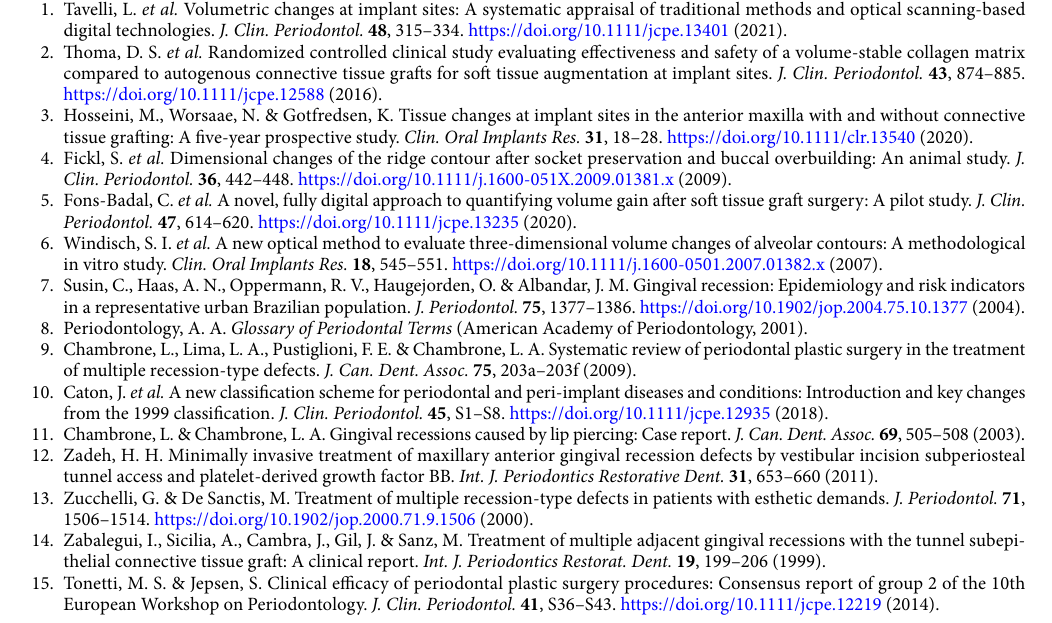
Two different methods to measure the soft-tissue thickness were applied using the protocol presented in Sup- plementary Table 1. The first method calculated the mean gingival thickness (2DTHK) and maximum gingival thickness (2DTHK Max) for each case at every time point, as seen in Fig. 3A. The second method involved a 3D assessment by limiting the recession in T0, T1, and T2 at the same time using transparencies to obtain the new volume of tissue over the denuded root for precise quantification of the tissue, as seen in Fig. 3B. In this case, the region of interest comprised the entire area of grafted soft tissue on the previously exposed root surface. Thus, the mean thickness of the marginal soft tissue (3DTHK) on the formerly exposed root surface, the mean gingival thickness (3DTHK), and maximum gingival thickness (3DTHKMax) were assessed for each case and each time point. Gingival margin thickness was measured using a new method that allows quantifying the margin thick- ness in a non-invasive way, as shown in Fig. 3C: two planes are defined, and the software calculates the distance between those two planes.